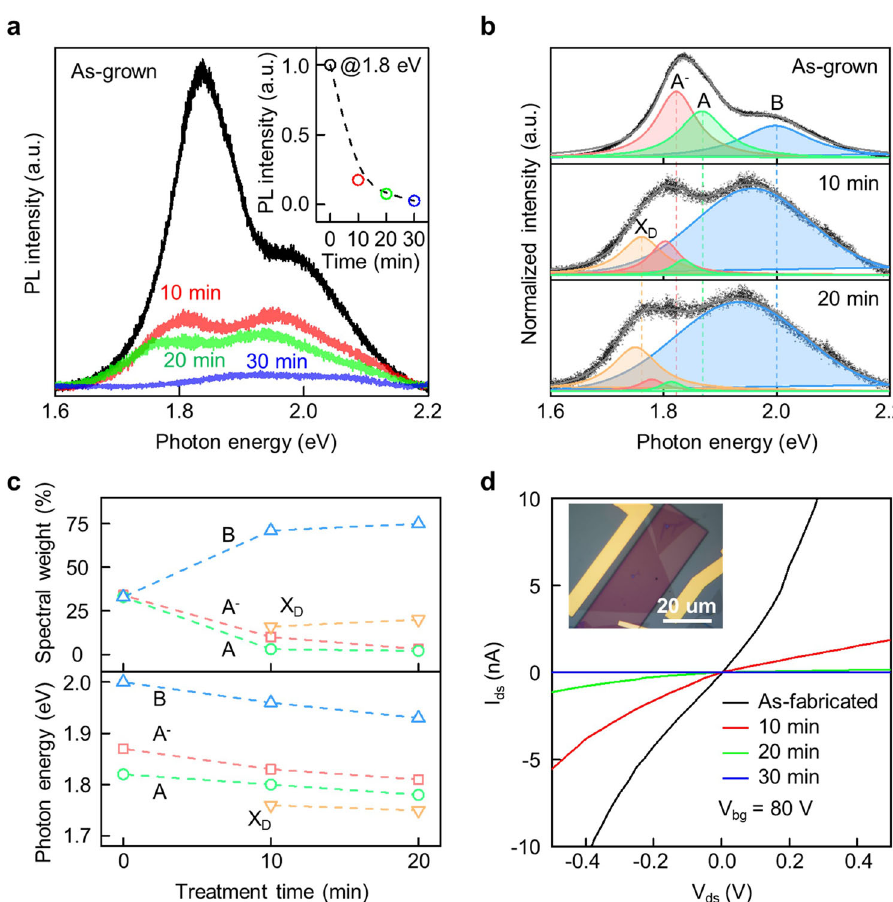
Fig. 6 Optical and electrical properties of MoS 2 and HP-MoS 2 . a PL spectra of MoS 2 and HP-MoS 2 with different treatment times, showing quenching behavior. Inset shows a change of PL intensity at 1.8 eV. b PL spectra fi tting result with increasing plasma treatment time. The intensity of PL spectra is normalized to maximum intensity. c Spectral weight and photon energy of PL peak contributions as a function of treatment time. d Output curves (I ds – V ds ) of MoS 2 FETs under 80 V of back gate voltage (V bg ) with increasing treatment time. The contact area of MoS 2 device was covered by PMMA to prevent damage of MoS 2 under metal electrodes. The inset shows optical image of fabricated